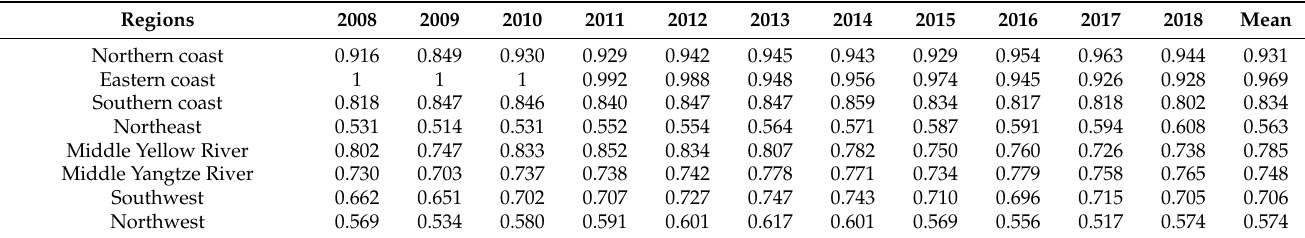
Table 5. ULGUE values for eight Chinese regions